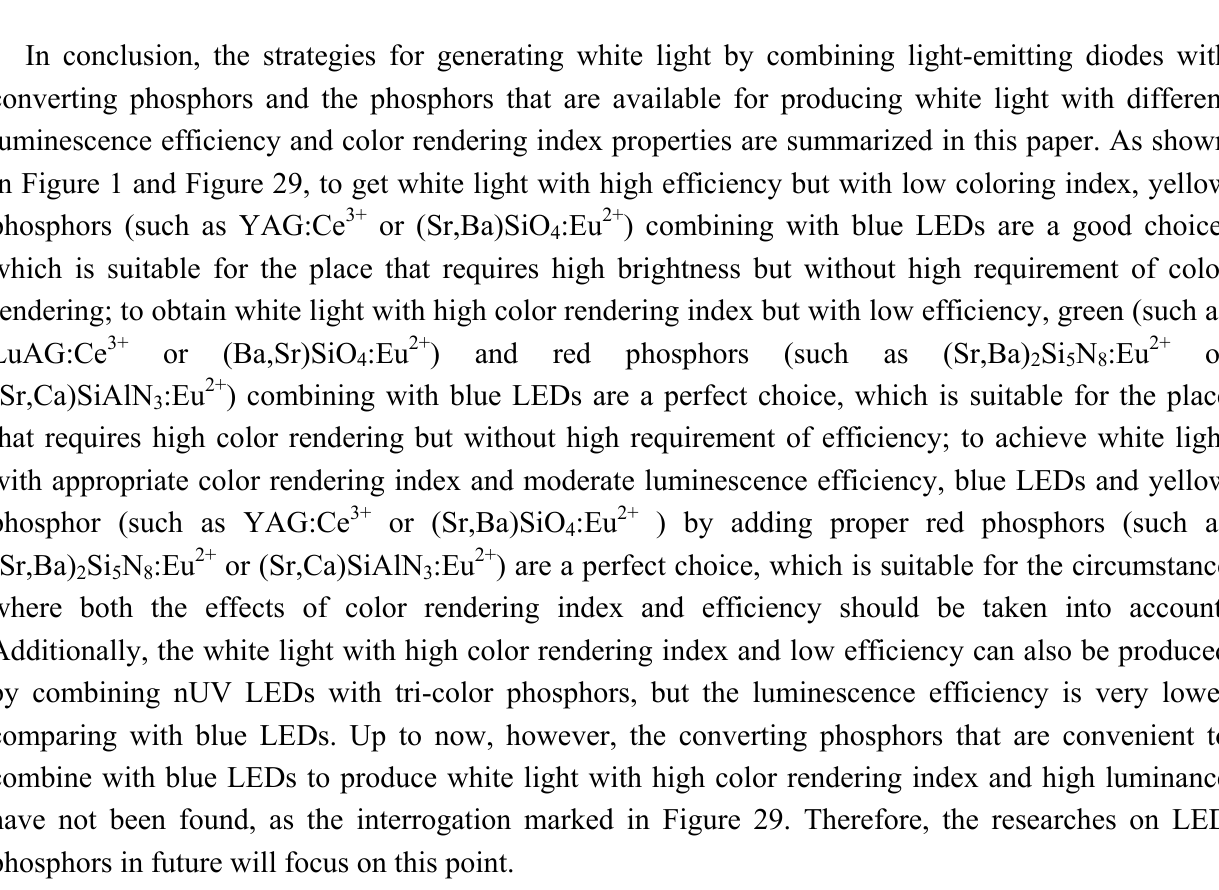
Ca ) SiAlN :Eu 2+ under 460 nm 0.02 0.75 0.25 0.98 3